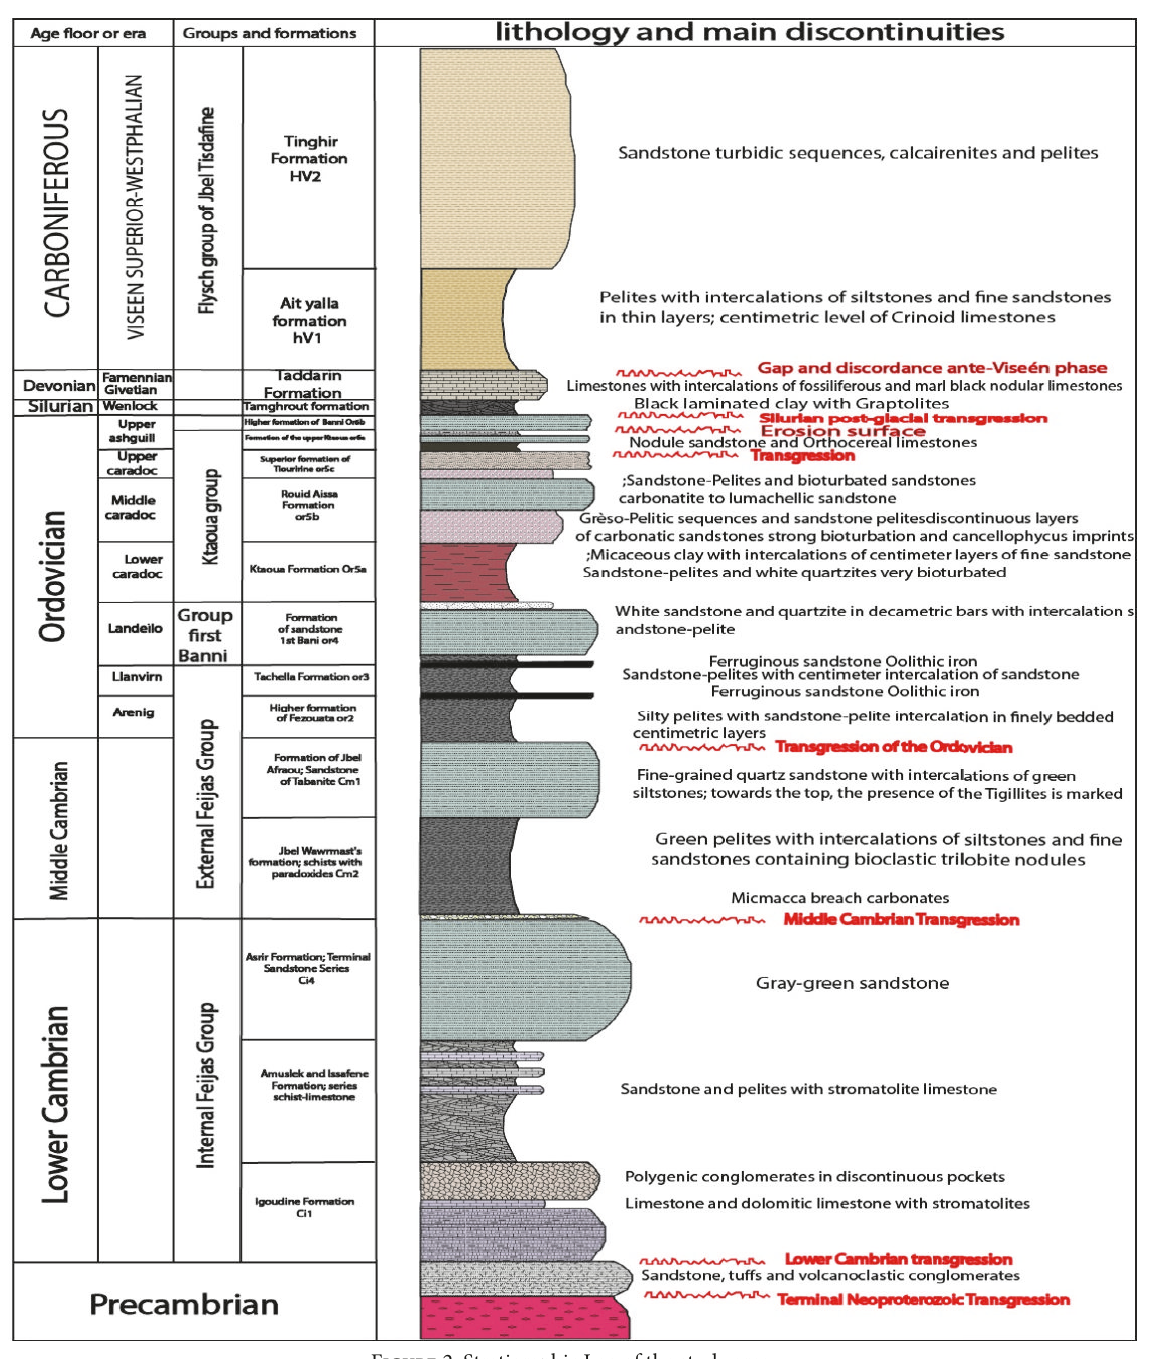
Figure 2: Stratigraphic Log of the study